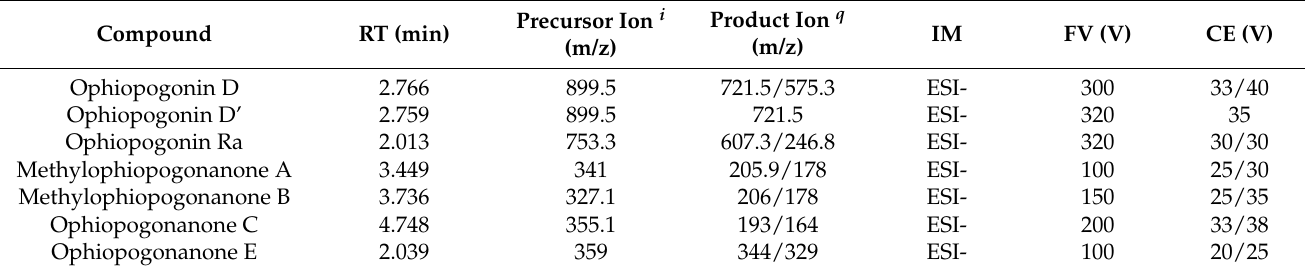
Table 1. LC-MS/MS parameters of the phenolic active substances’ quantitative